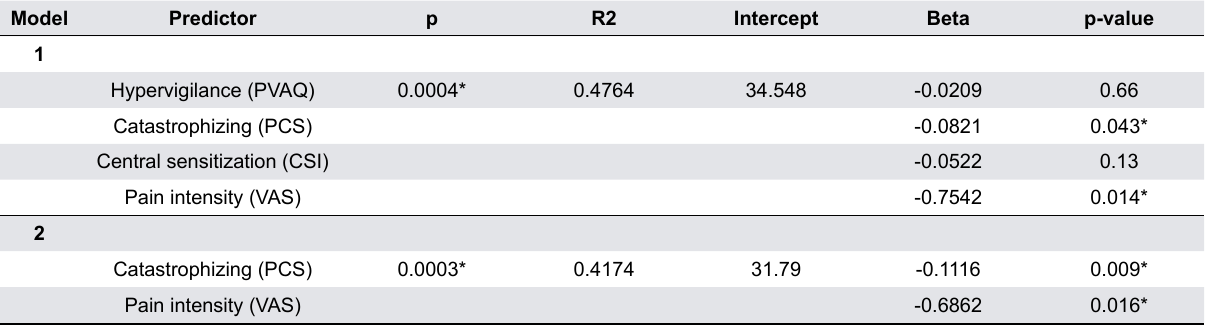
*p<.05; p: significance of the multiple regression model tested; p-value: significance of partial regression coefficients; R2: coefficient of determination of the multiple regression model tested; Beta: partial regression coefficient; Intercept (or Constant): value of the response variable when predictor variables are equal to zero.